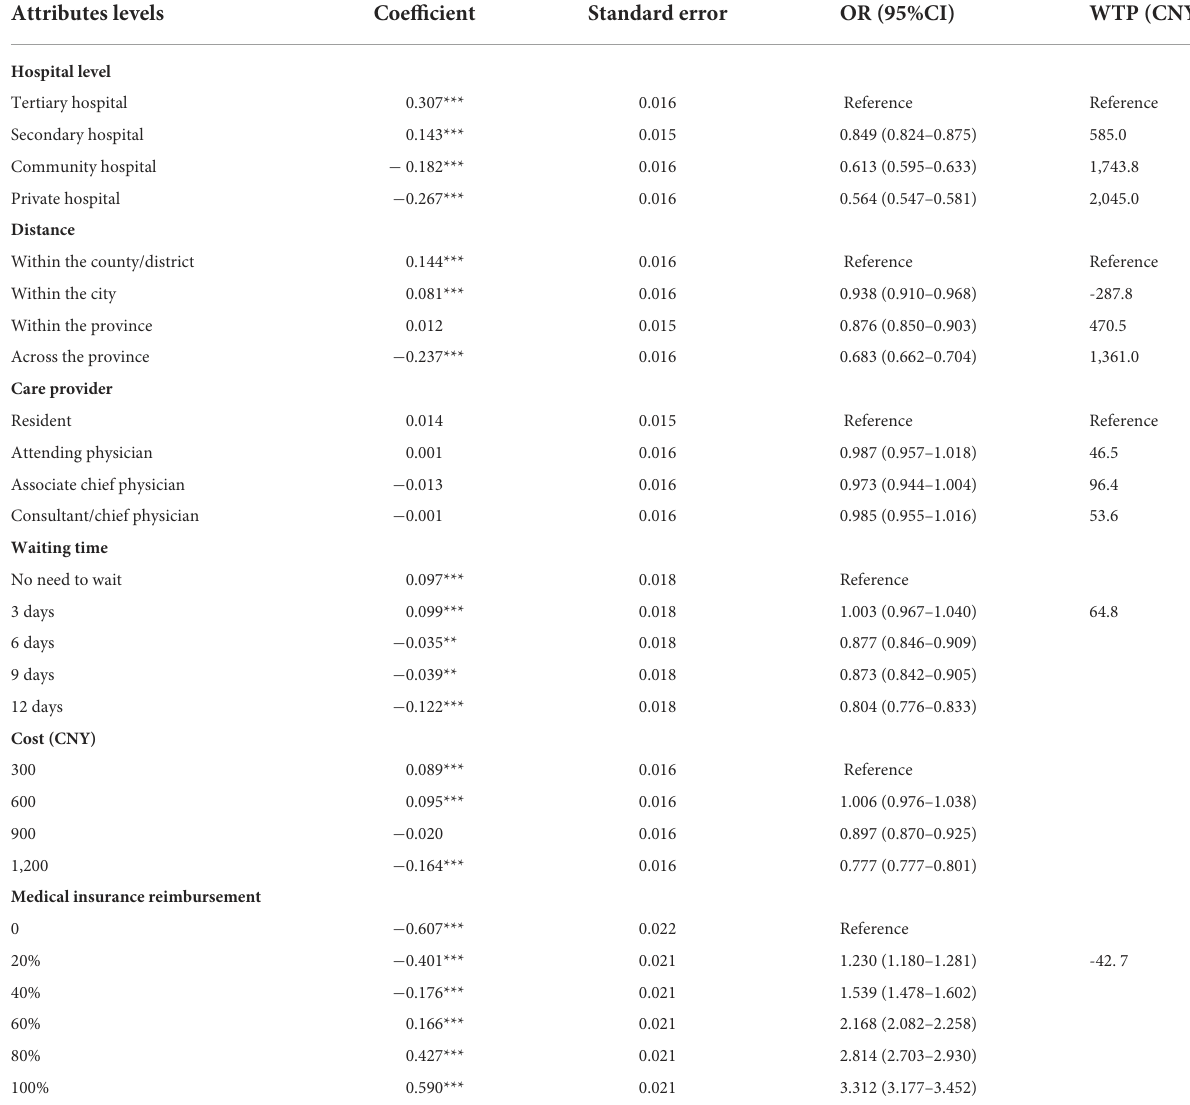
TABLE 4 Attributes and levels of chronic non-infectious diseases